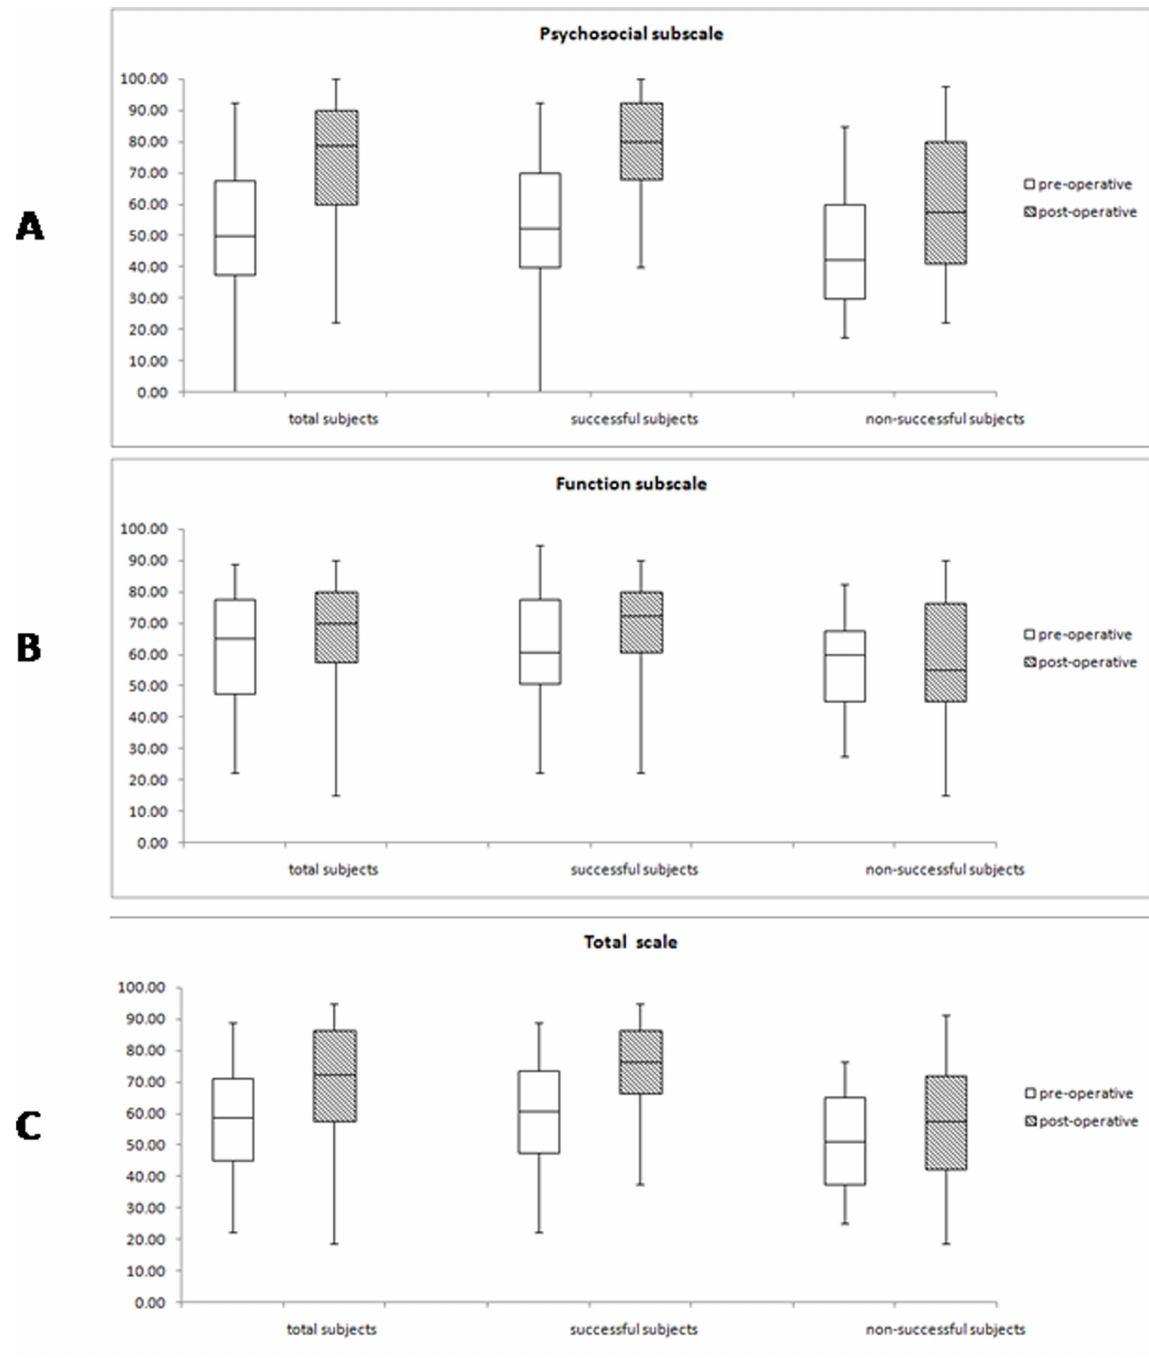
Fig 1. Pre-and post-operative AS-20 scores. A: Psychosocial subscale, B: Function subscale, C: Total